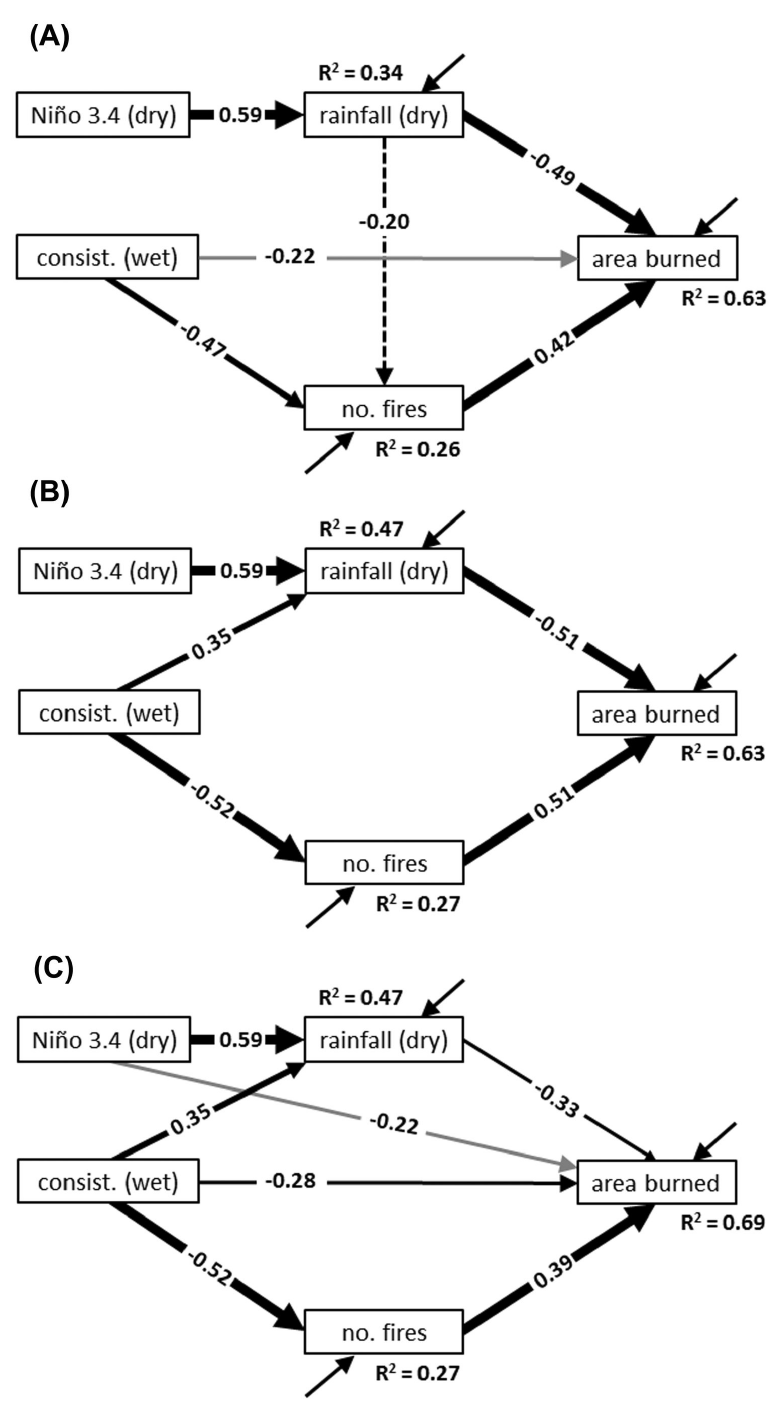
Figure 4. Structural equation models describing effects of selected climate variables on the wildfire regime. The models include: (A) our starting, theory-based model (BCC = 37.0; χ 2 = 9.3, df = 4, p = 0.05), (B) the second “best” exploratory model according to BCC values (BCC = 32.4; χ 2 = 7.1, df = 5, p = 0.21), and (C) the “best” exploratory model (BCC = 32.3; χ 2 = 2.0, df = 3, p = 0.57). Paths are labeled with numbers, which are standardized partial regression coefficients. The significance of these coefficients is shown with differently weighted lines (dashed = non-significant, gray = p ≤ 0.10, thin = p ≤ 0.05, moderate = p ≤ 0.01, and thick = p ≤ 0.001). Models are drawn using 30 years of climate and wildfire data from the Avon, Park Air Force Range, south- central Florida, USA (1978-2007). doi: 10.1371/journal.pone.0075946.g004 PLOS ONE |